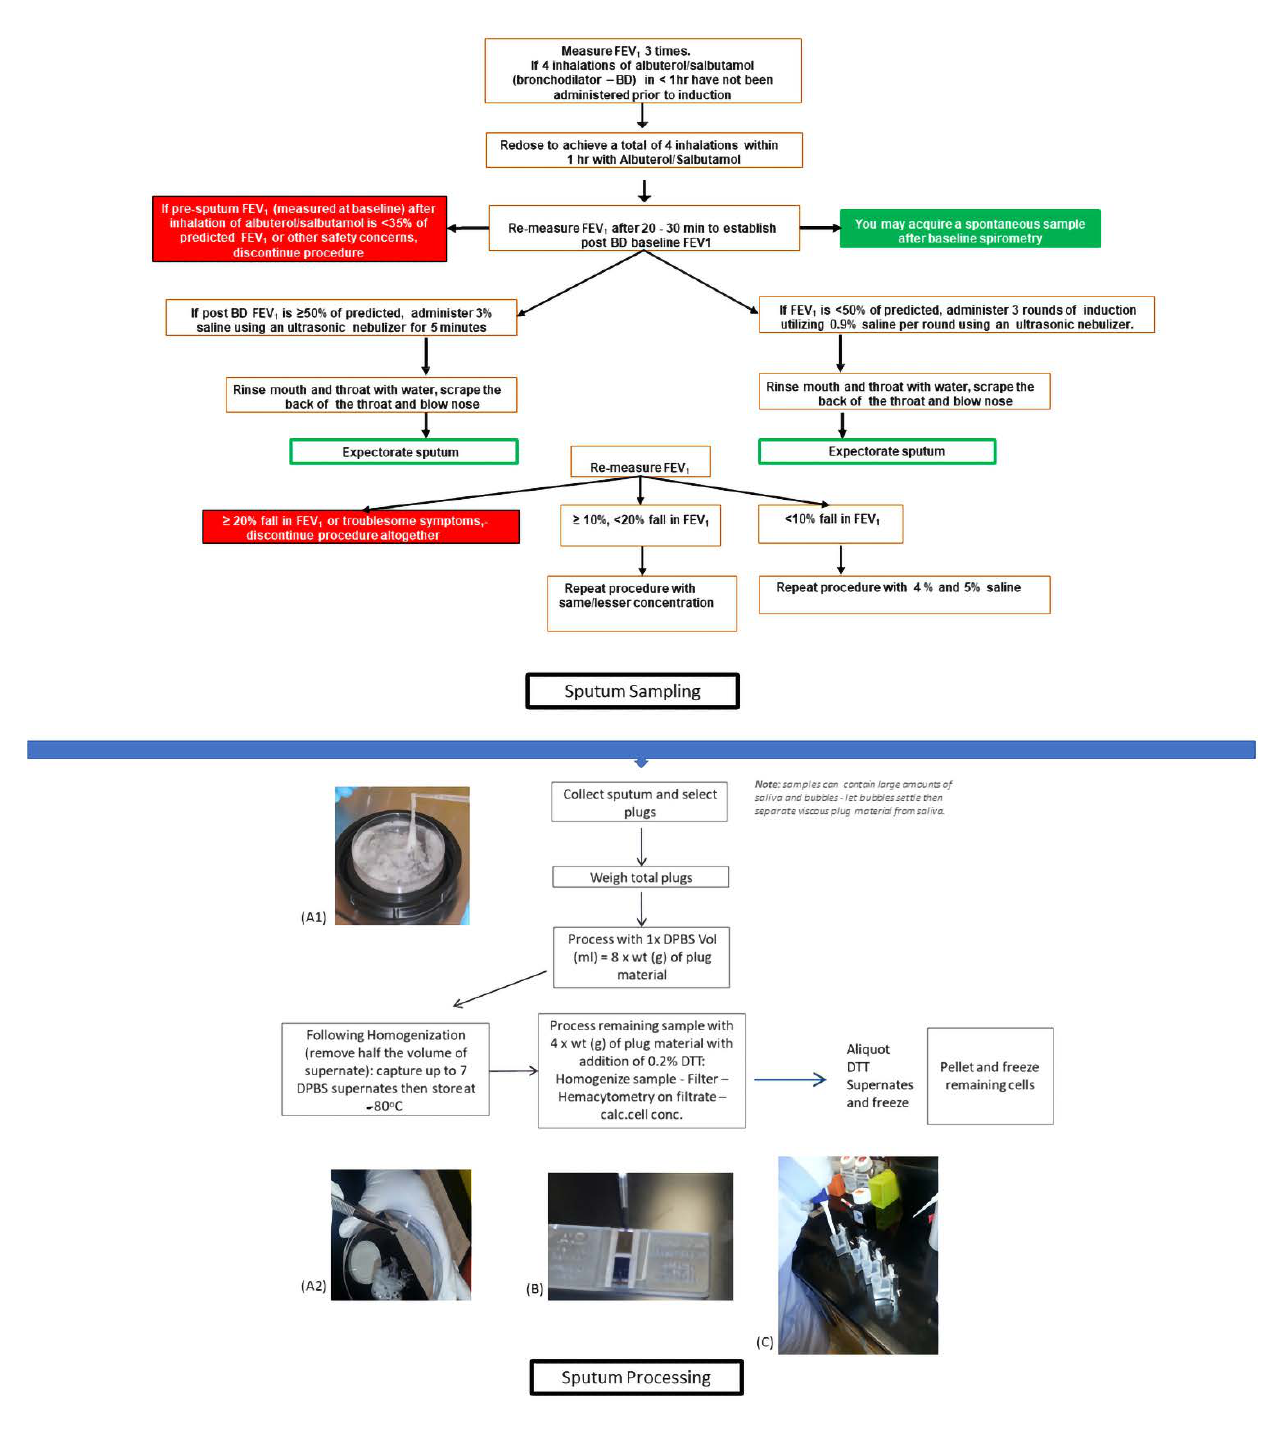
Figure 2. Proposed protocol for Induced Sputum Sampling and Processing (calc.cell.conc = calculate cell concentration, FEV1 = Forced expiratory Volume in the 1st second, DPBS = Dulbecco’s phos- phate-buffered saline, DTT = dithiothreitol, wt = Weight total). ( A1 ) Sputum is first collected in a petri dish ( A2 ) Plugs are selected ( B ) Total cells and cell viability are calculated from the sample filtrate ( C ) Cytospin set up (pipette delivery of sample into